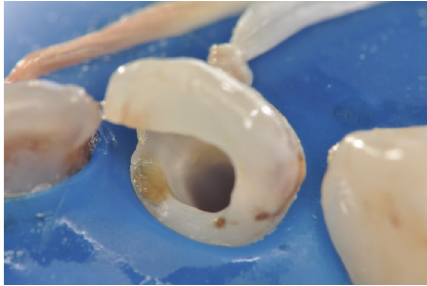
Figure 6: Use of methylene blue solution (50 𝜇 g/mL) as a photosen- sitizing agent and preirradiation time of 5 minutes.